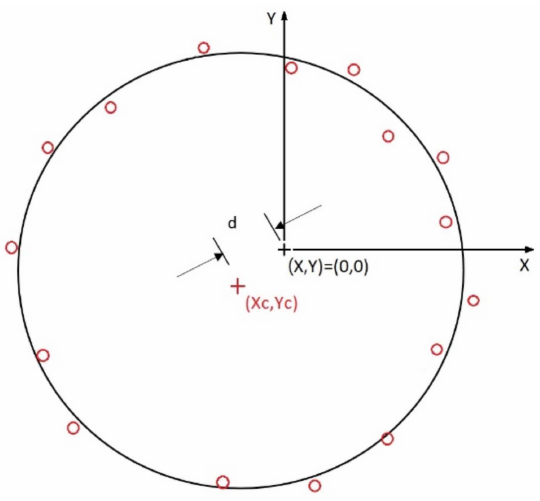
Figure 3. Calculation of concentricity (d) at specified Z-plane.